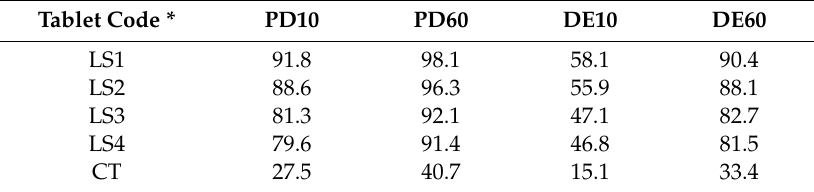
Figure 7. Dissolution profiles of glyburide (GLY) from liquisolid tablets (LS 1–4) and from the commercial tablet (Gliboral ® ) and the reference conventional tablet (CT). Table 3. Dissolution parameters of glyburide from liquisolid (LS) and conventional (CT) tablets in terms of percent dissolved (PD) and dissolution efficiency (D.E.) at 10 and 60 min.